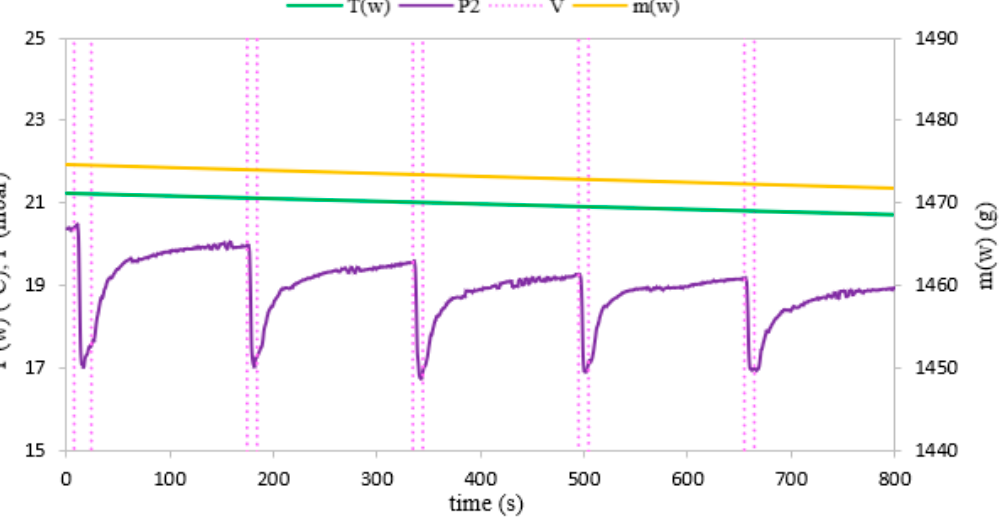
Figure 7. The changes of pressure, temperature and mass of evaporated water with time profiles in the evaporator corresponding to fluidized bed conditions.